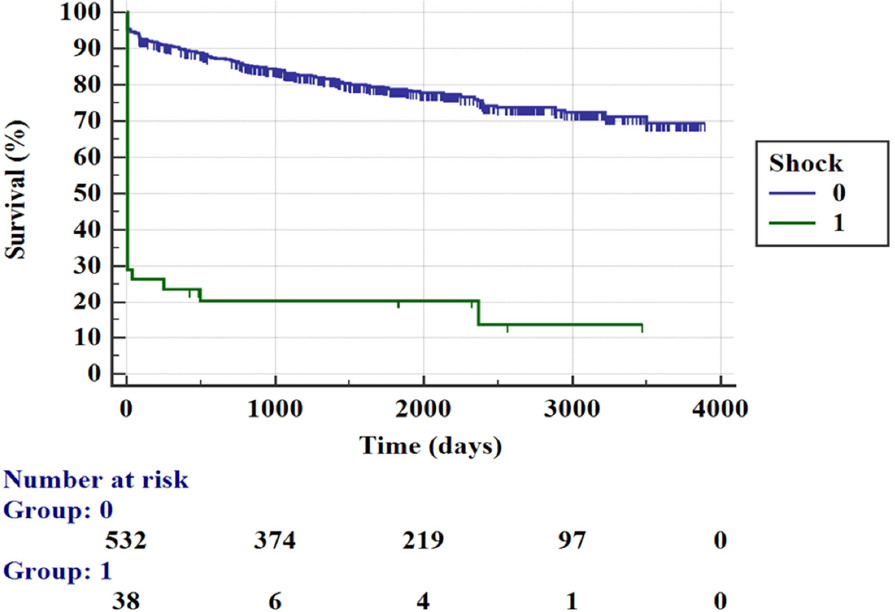
Figure 2. Kaplan–Meier curves for mortality rate according to the presence of cardiogenic shock at admission.